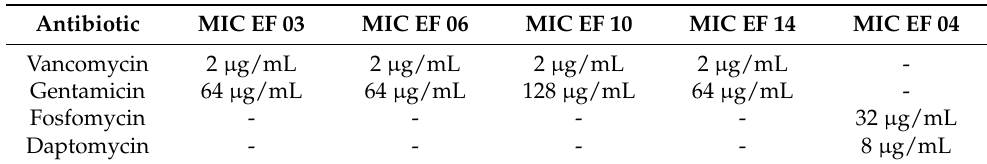
Table 1. Minimal inhibitory concentration (MIC) values of planktonic E. faecalis (EF) strains deter- mined by broth